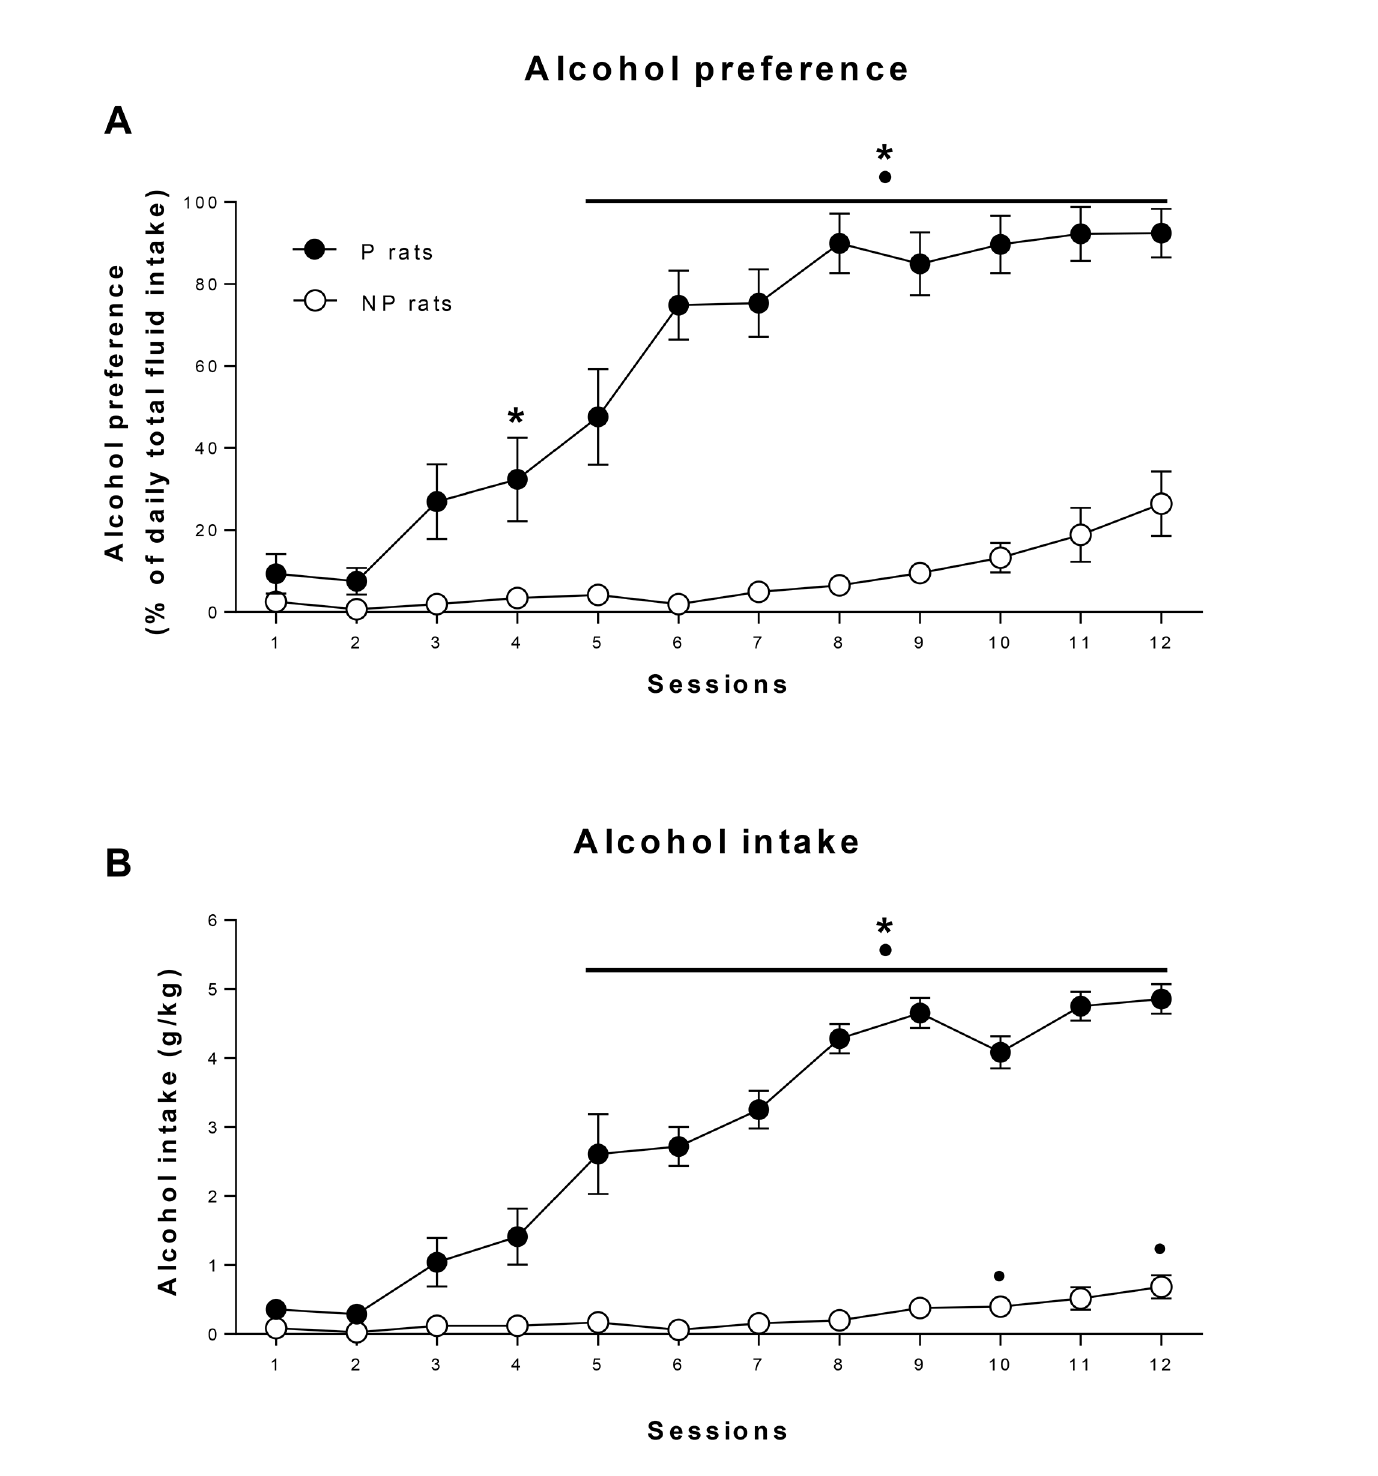
Fig 3. Intermittent access two-bottle choice procedure. Data represent the mean ± SE of alcohol preference (a) and alcohol intake (g/kg/day) (b) during the 12 sessions of intermittent access to alcohol in alcohol-preferring rats (P, closed squares) and alcohol-non-preferring rats (NP, open circles). All p < 0.05 (adjusted after Bonferroni correction): ( * ) significant group differences, ( (cid:129) ) vs session 1.